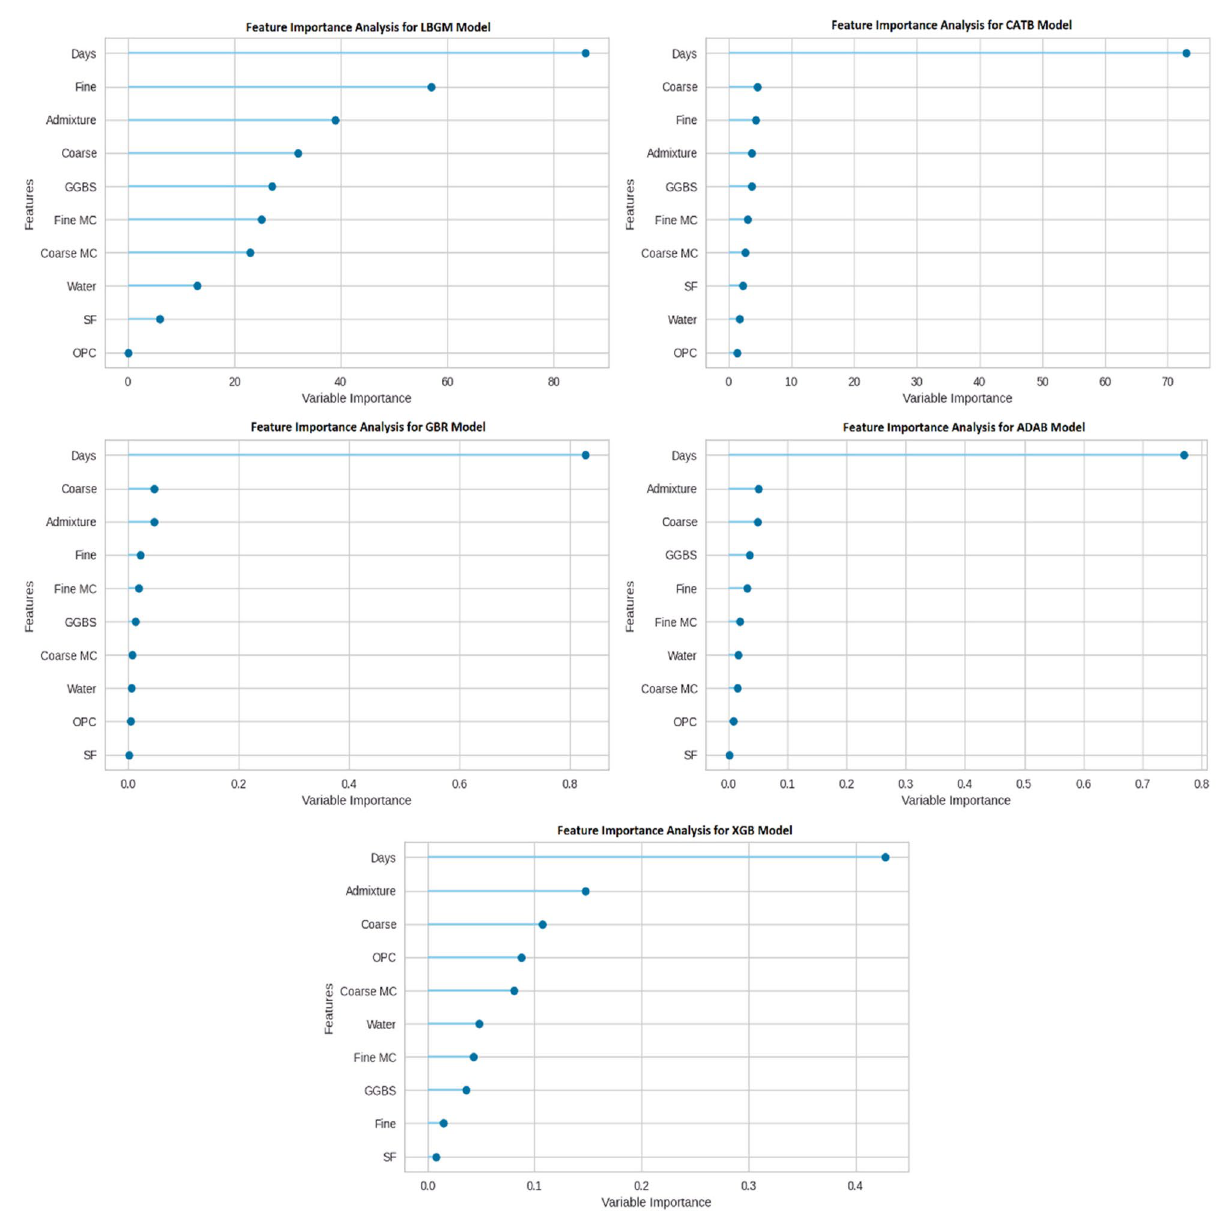
Figure 10. Feature importance analysis of BML